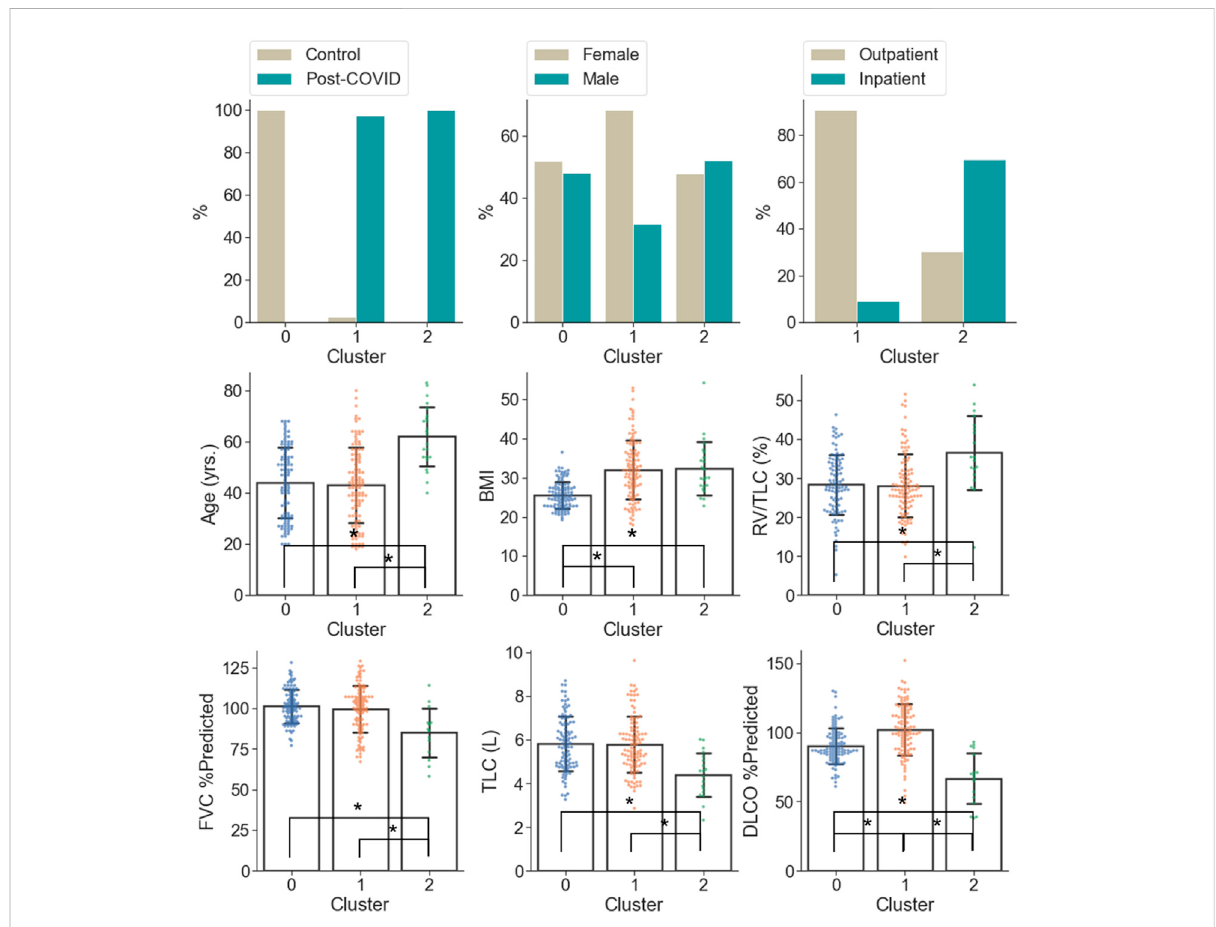
FIGURE 5 Demographic and PFT data which were signi fi cantly different ( α = 0.05) between the clusters. A “ * ” denotes signi fi cance between two clusters and the range of error bar is the mean ± the standard